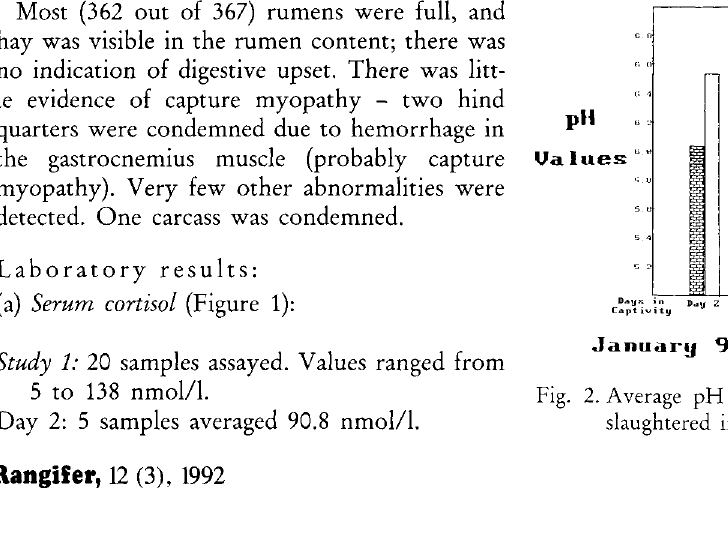
Fig. 2. Average pH values of meat from muskoxen slaughtered in January/91 and